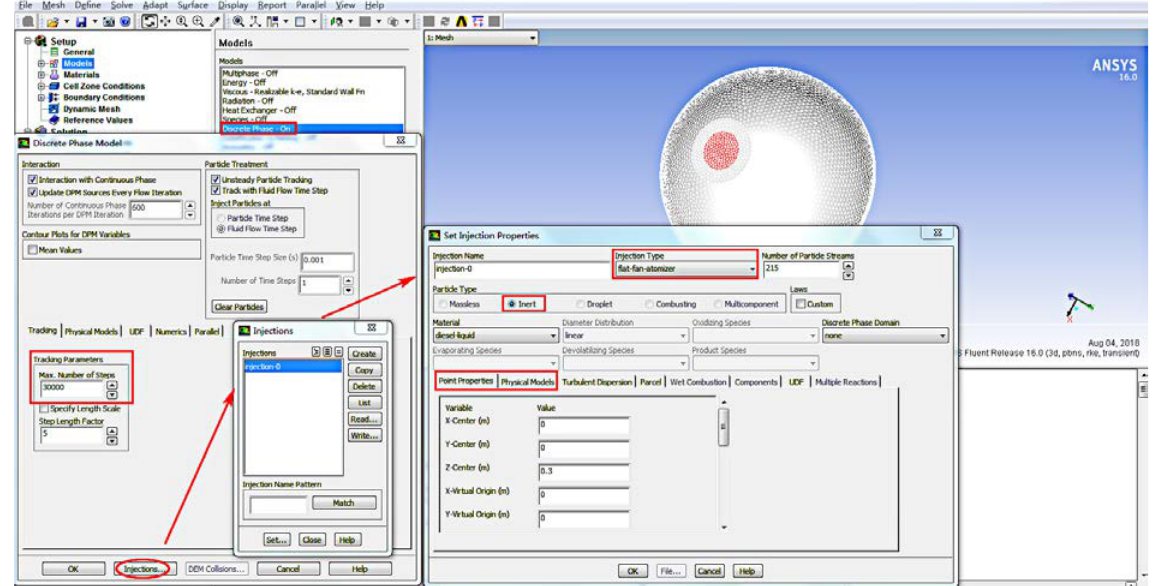
Figure 10. Condition setting for inlet-separated boundary of single-layer spherical recovery cover.